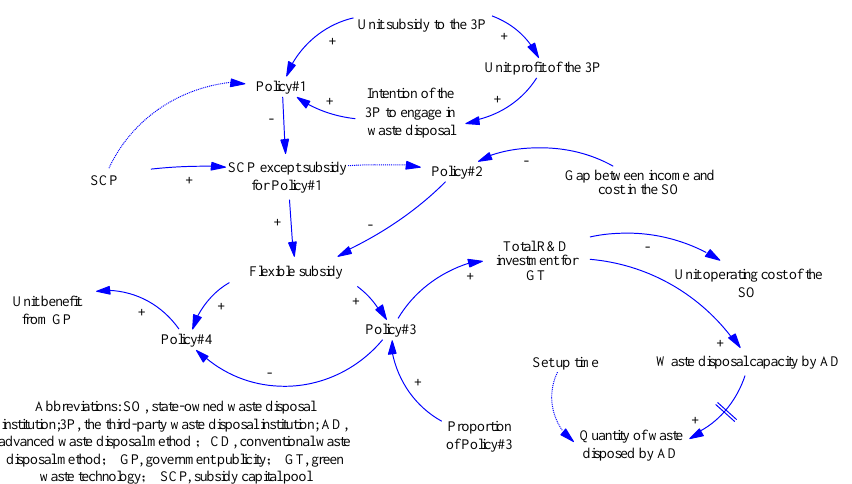
Figure 4. The CLD of the government subsidy policy module. Table 7. Data